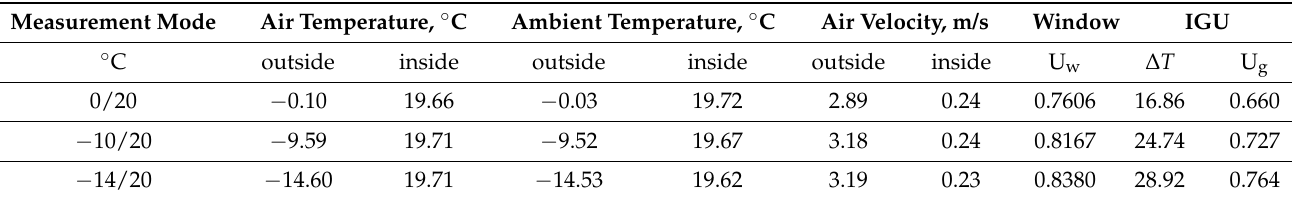
Table 2. Results of double-glazed window No. 1’s (characteristics are in presented Table 1) measurements in a GHB. Measurement